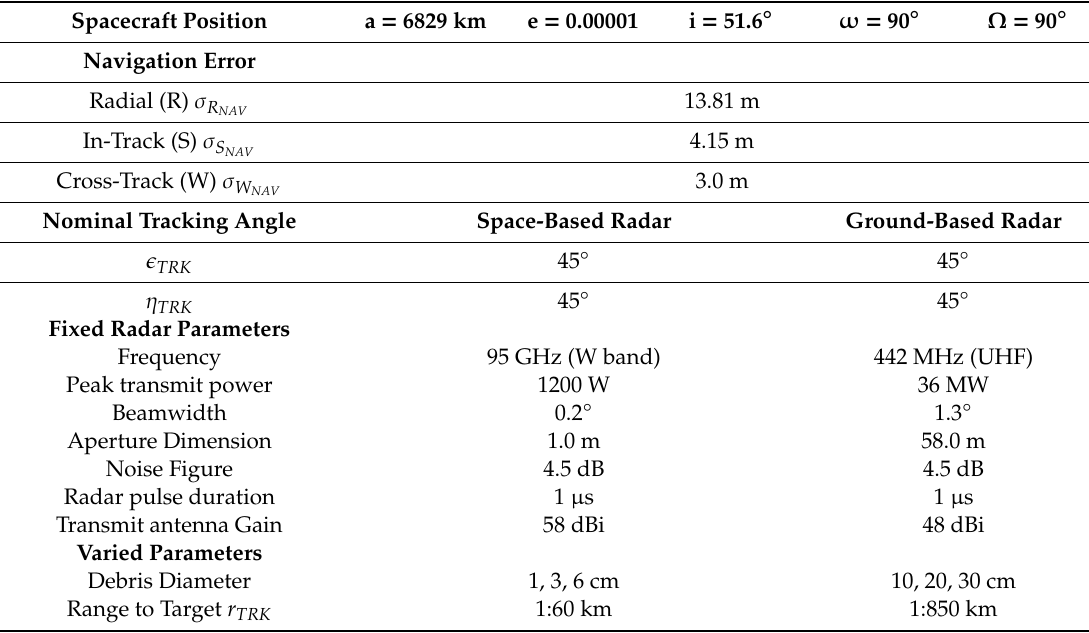
Table 4. Ground and Space-based tracking scenario